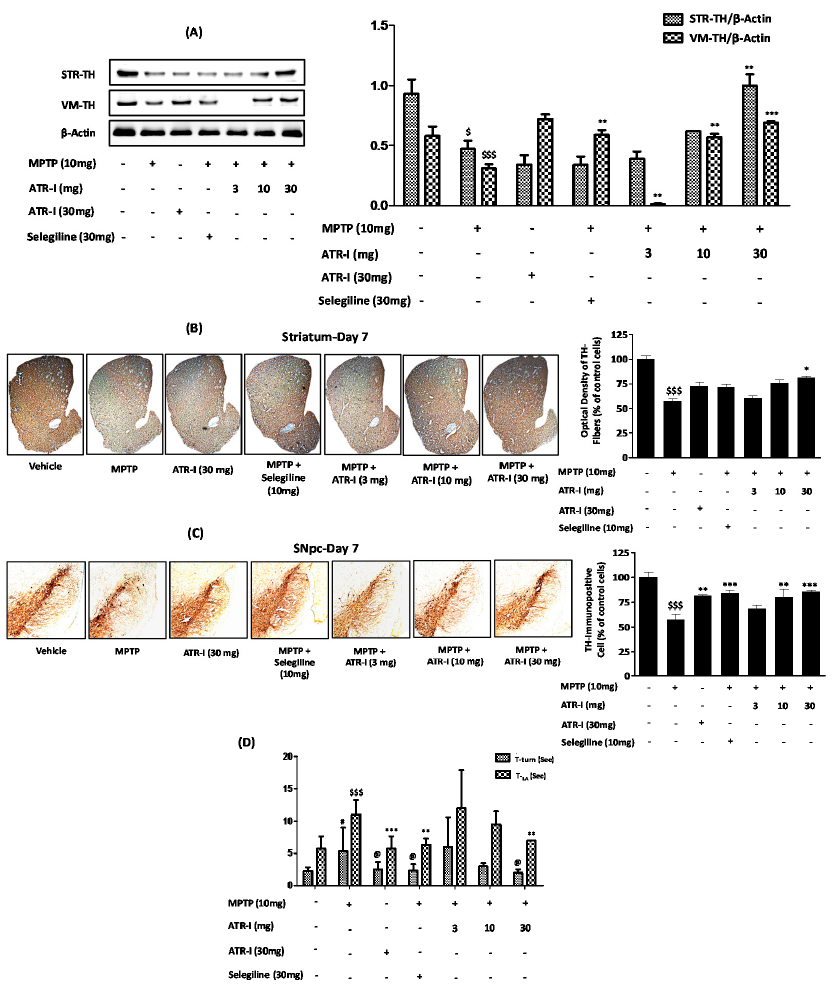
Figure 7. Protective effects of ATR-I against MPTP in STR and VM. Western blot for TH protein expression in STR and VM ( A ); Representative coronal images of TH-positive striatal fibers ( B , C ) SNpc neurons. Densitometric analysis for TH protein expression is provided in the right panel ( n =